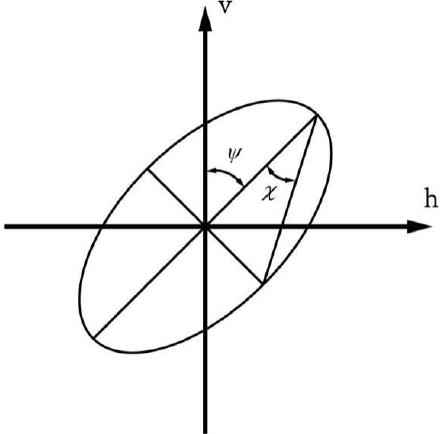
Figure 2. Polarization of the electromagnetic wave.